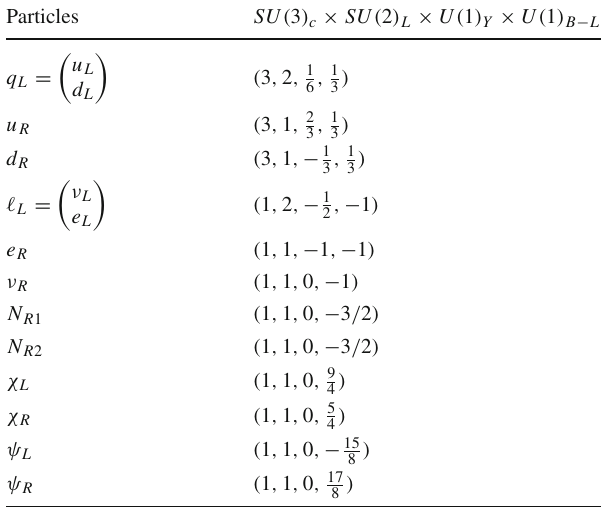
Table 1 Fermion content of the model Particles